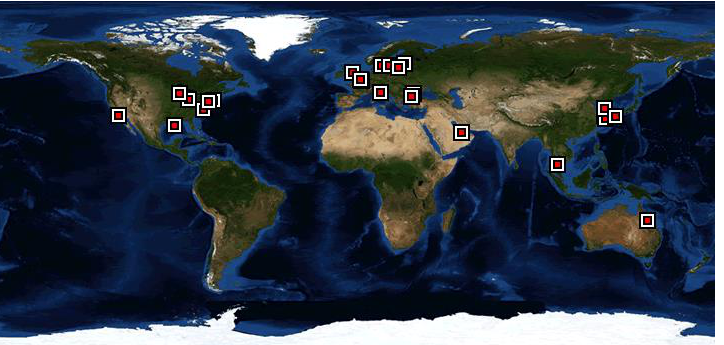
Figure 1. Global AERONET-OC network. The red square are all the stations with Version 3 Direct Sun Algorithm for processing radiative data and products available at Level 2.0 (Figure from website: https://aeronet.gsfc.nasa.gov/cgi-bin/draw_map_display_seaprism_v3 accessed on 22 January 2021).